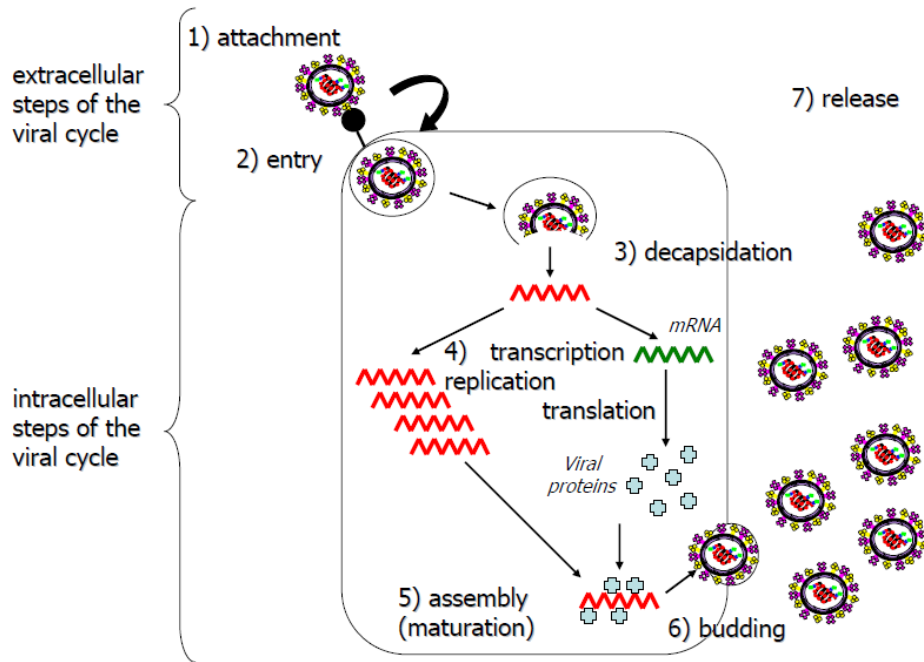
Figure 3. Simplified diagram of the viral life cycle. Extracellular (1, 2 and 7) and intracellular (3, 4, 5 and 6) steps are